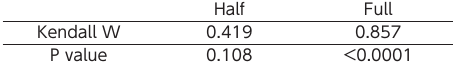
Table 2. Results of statistical tests regarding the rate of concordance for evaluation points among evaluators